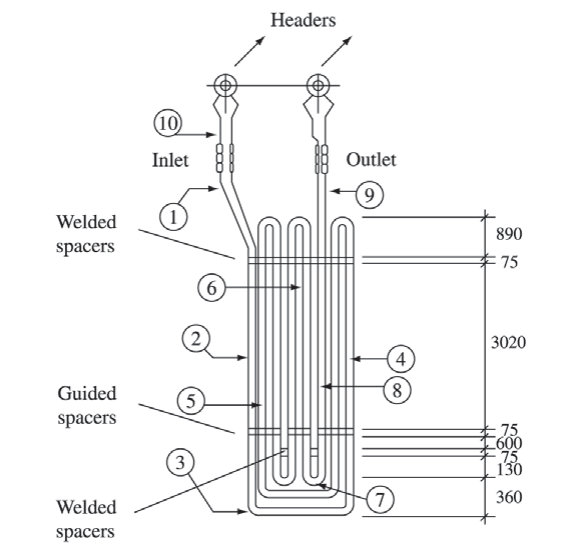
Figure 1. Creep life assessment based on cavity classification 2 .